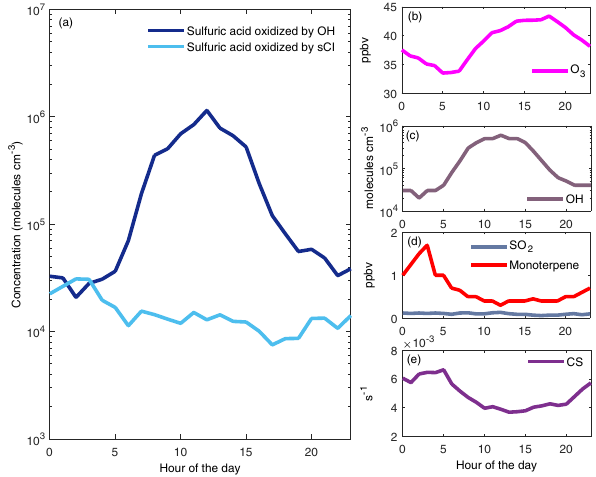
Figure 5. Example of sulfuric acid concentration produced by OH and sCI in ambient boreal forest conditions (a) . The precursor gas concentrations and condensation sink used are shown in plots (b–e)